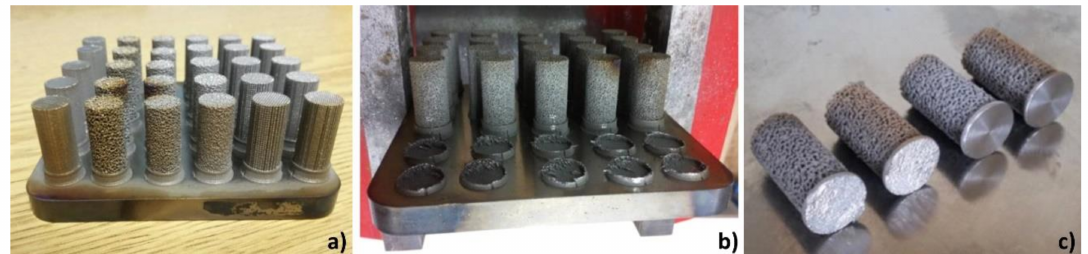
Figure 6. ( a ) test specimens after the thermal annealing process, ( b ) removal of specimens from the platform, ( c ) untreated and treated test specimen base.